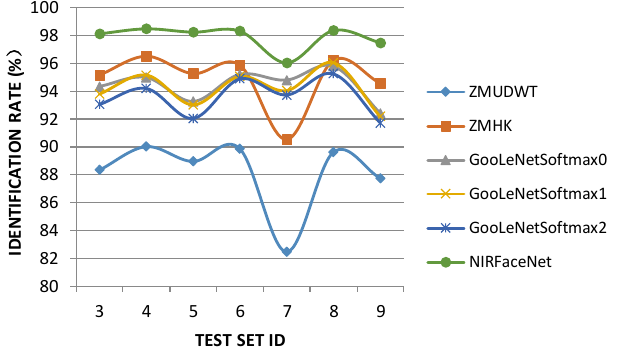
Figure 6. The identification rates of algorithms tested on Test Sets 3–9.